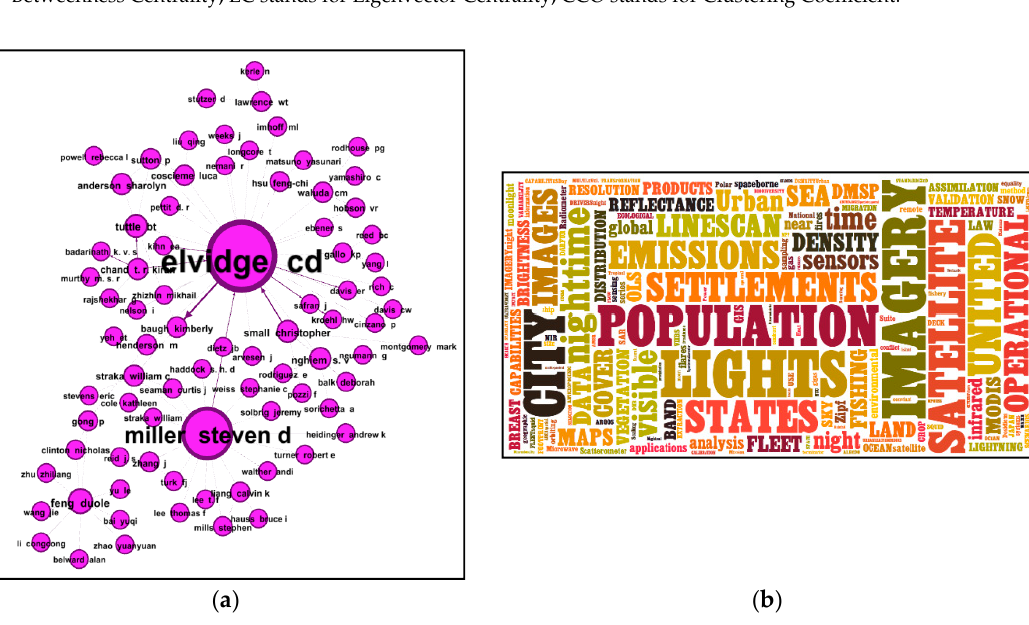
Figure 4. Elvidge, C.D.–Miller, S.D. research community: ( a ) co-author network; ( b ) related topics.